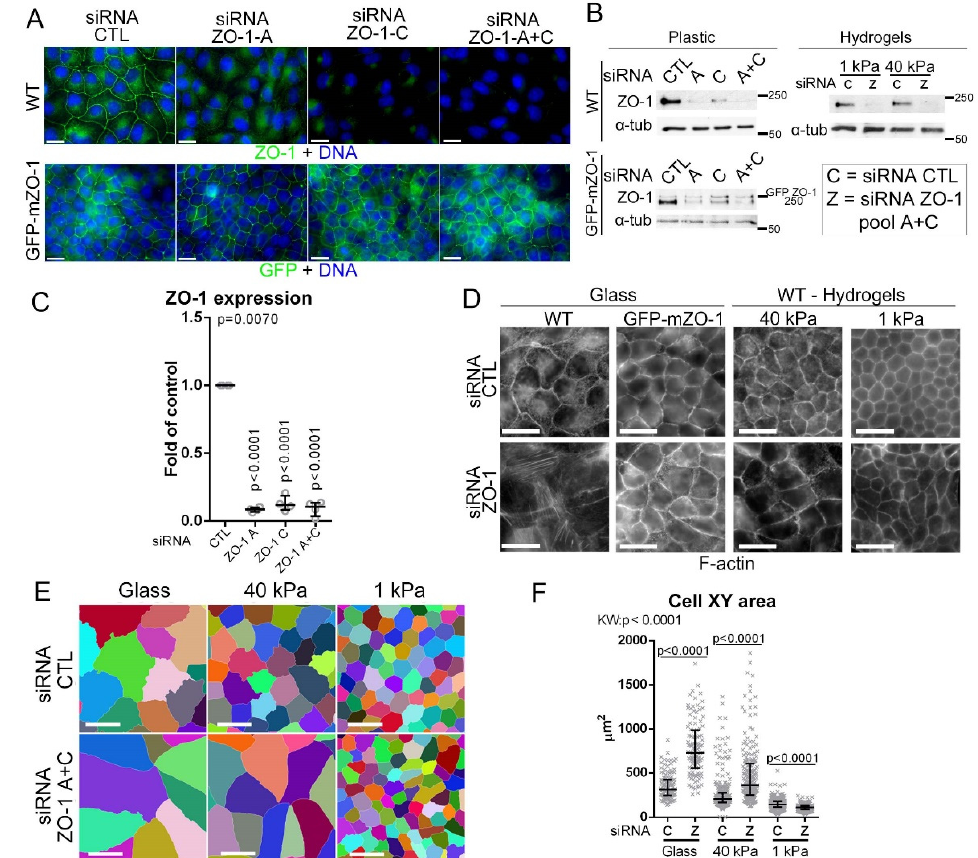
Figure 1. ZO-1 regulation of cell morphogenesis is ECM stiffness-dependant. ( A – C ) siRNA-mediated depletion of ZO-1 in control and mouse GFP-tagged ZO-1 (GFP-mZO-1)-expressing MDCK cells using two different siRNAs against ZO-1. Cells were analysed by immunofluorescence (( A ), upper row, ZO-1; lower row, GFP; nuclei were labelled with Hoechst) or immunoblotting (( B , C ); α -tubulin was blotted as a loading control). ZO-1 downregulation was quantified by densitometry (( C ), data points are derived from independent determinations). ( D – F ) siRNA transfected wild-type and GFP-ZO-1 cells were seeded on ECM of different elasticities. Cells were stained for F-actin ( D ) and 2D cell segmentation was performed based on junctional immunostaining using the method described by Haas et al. (see also Materials and Methods) ( E , F ) to quantify single-cell XY areas (data points show individual cells analysed) [9]. Magnification bars, 20 μ m.